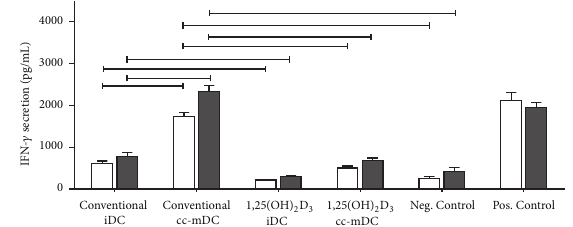
Figure 5: Allogeneic T cell-stimulatory capacity of 1,25(OH) 2 D 3 - treated DC before and after cryopreservation. Fresh and frozen iDC and mDC were cocultured with allogeneic responder PBL at a 1: 10 ratio. Nonstimulated PBL served as negative control, while allogeneic responder cells stimulated by mitomycin C-treated PBL (10: 1 responder/stimulator ratio) were used as positive control. After 6 days, cell culture supernatant was collected and the secreted level of IFN- 𝛾 was used as a measure for allostimulatory capacity by means of IFN- 𝛾 ELISA. Each condition was measured in triplicate. Resultsofhealthycontrols( 𝑛 = 5 )areexpressedasmean ± SEM.The open bars and black bars represent the measured IFN- 𝛾 secretion before cryopreservation and after cryopreservation,